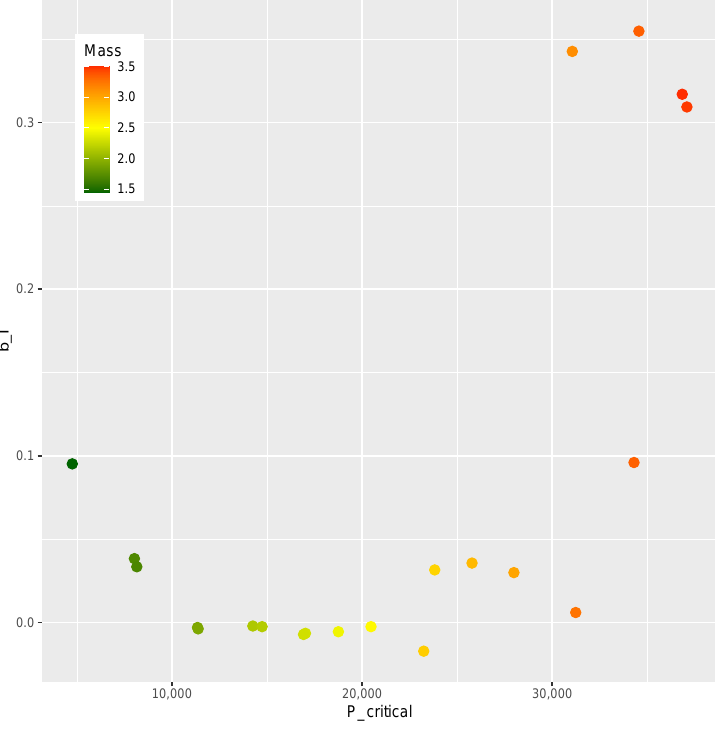
Figure 21. P critical and b I at critical